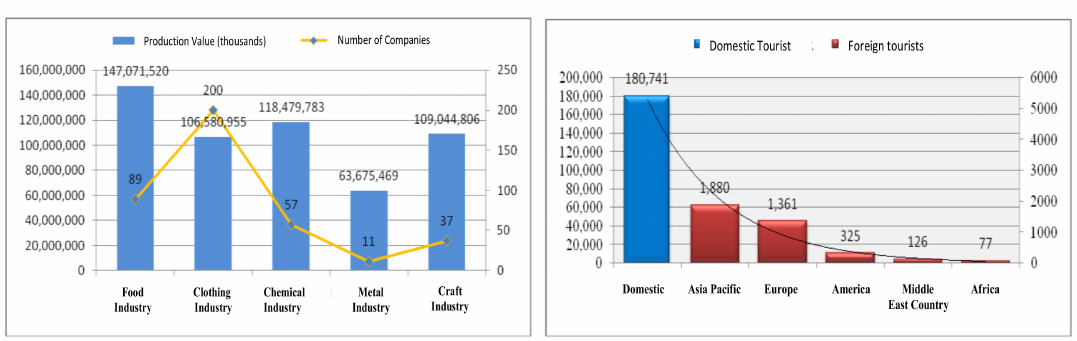
Figure 5. Total Production of Industrial and Tourist Products in Bulukumba Regency. Source: Reference